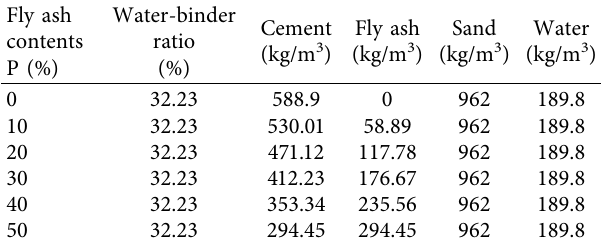
Table 3: Te ratio of each material in